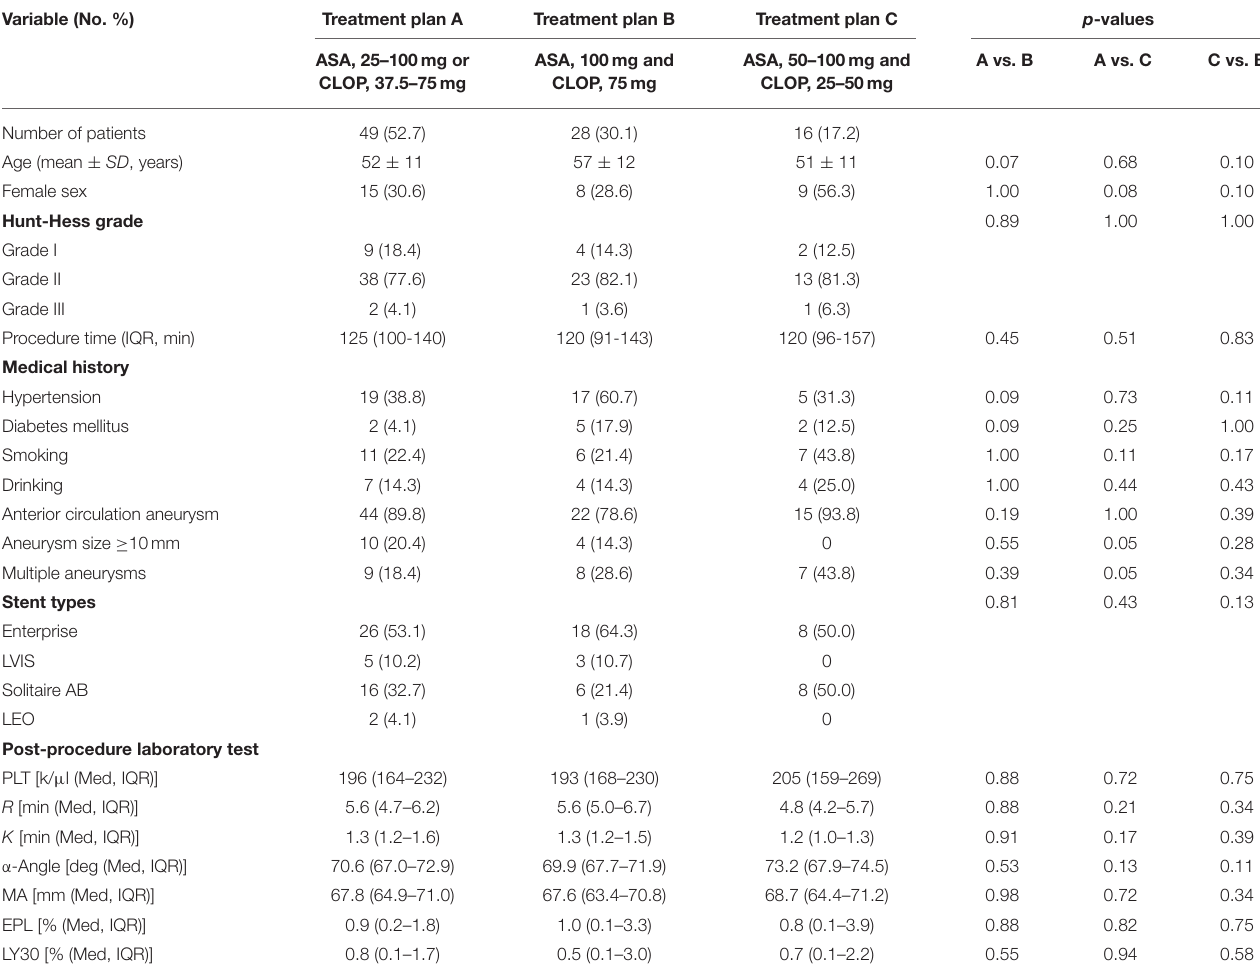
TABLE 2 | Baseline characteristics of the patients who underwent SAC with individualized antiplatelet therapy. Variable (No.